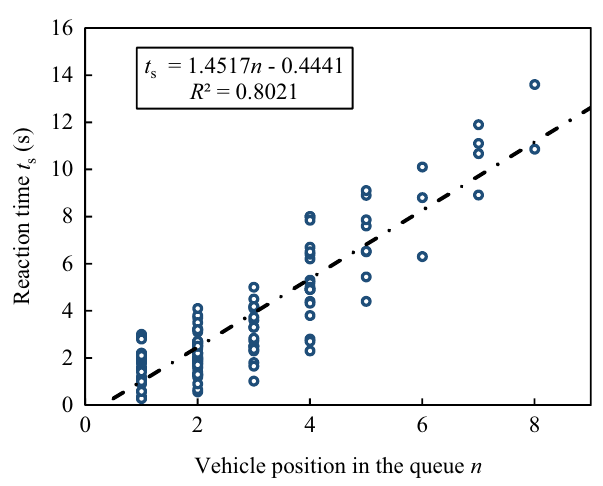
Fig. 4 Relation between driver reaction and vehicle position in the queue